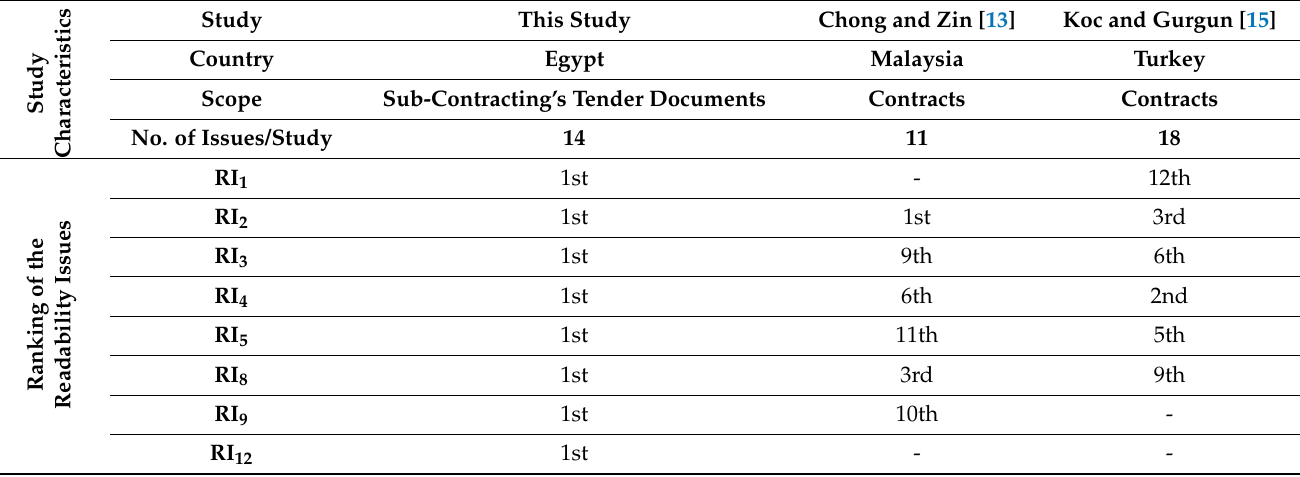
Table 6. Rankings of the top-eight frequent issues of the readability in the developing